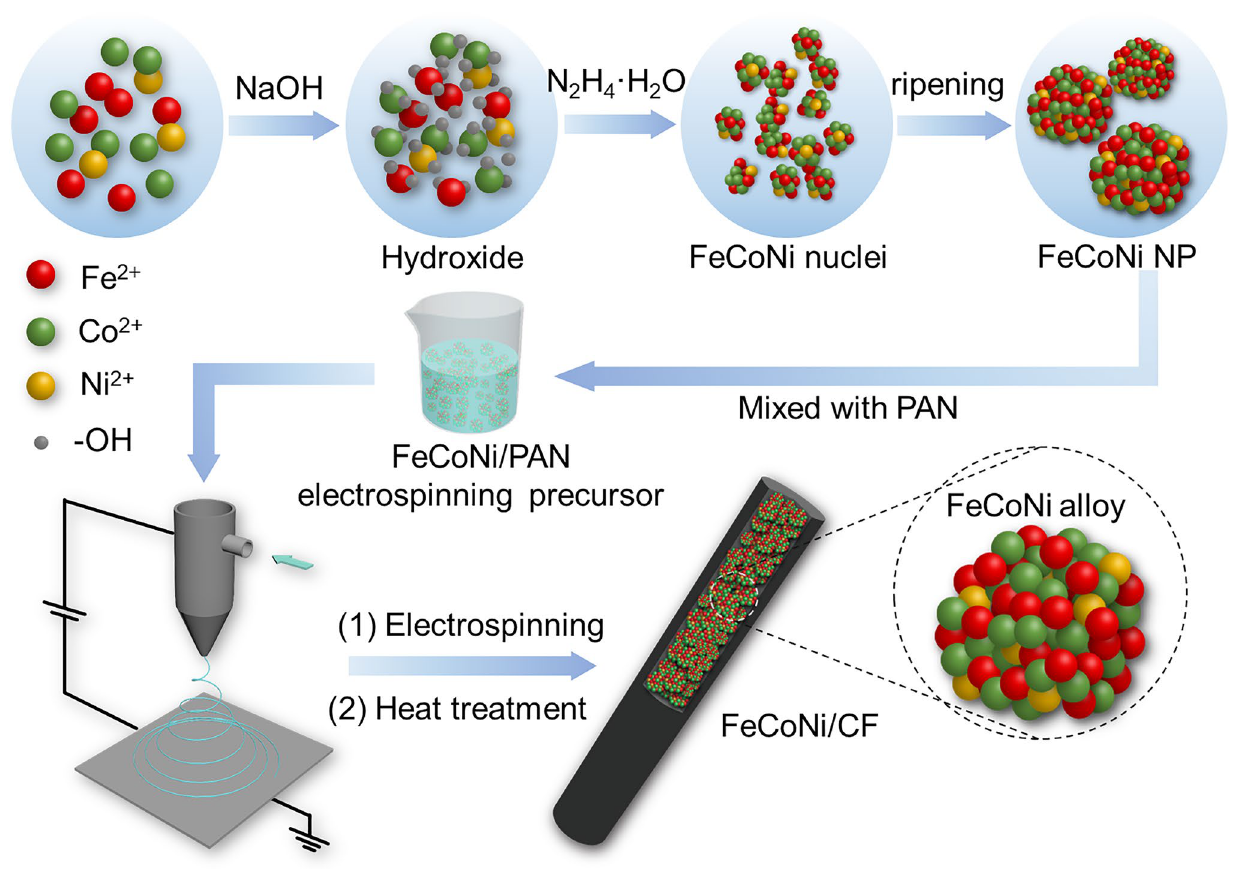
Fig. 1 Schematic illustration of the synthetic strategy for FeCoNi/CF